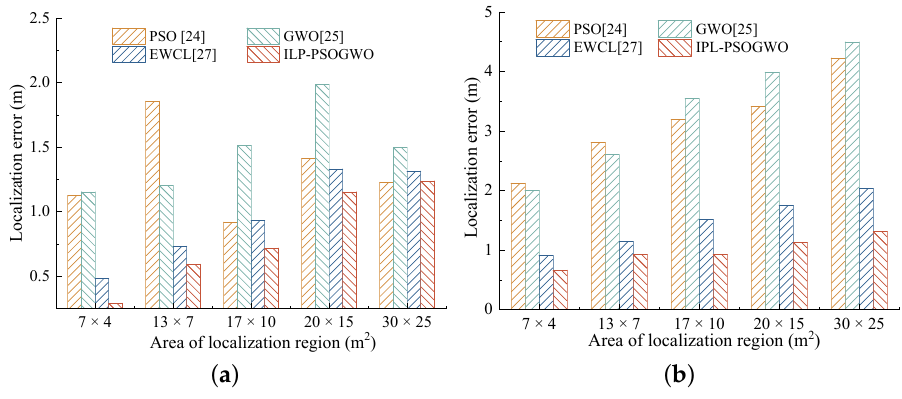
Figure 13. Impact of area of localization region on localization error. ( a ) LOS. ( b )